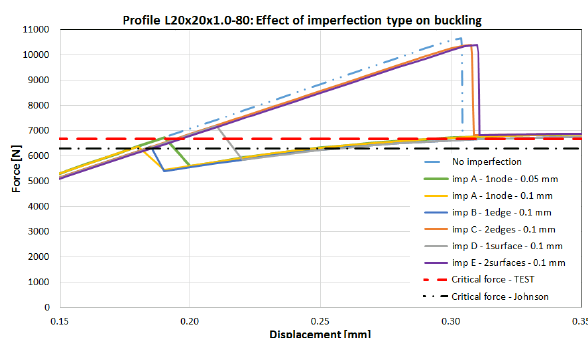
Figure 9. Final graphic comparison of force distributions for all types of imperfections